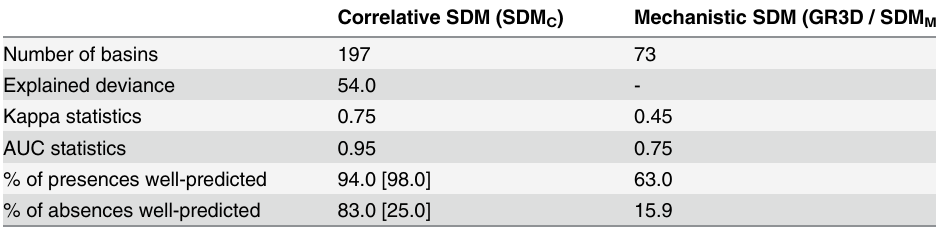
Table 3. Predictive performances of the correlative and mechanistic SDMs. Values in brackets corre- sponded to percentages when only basins from the GR3D physical environment were considered (73 over